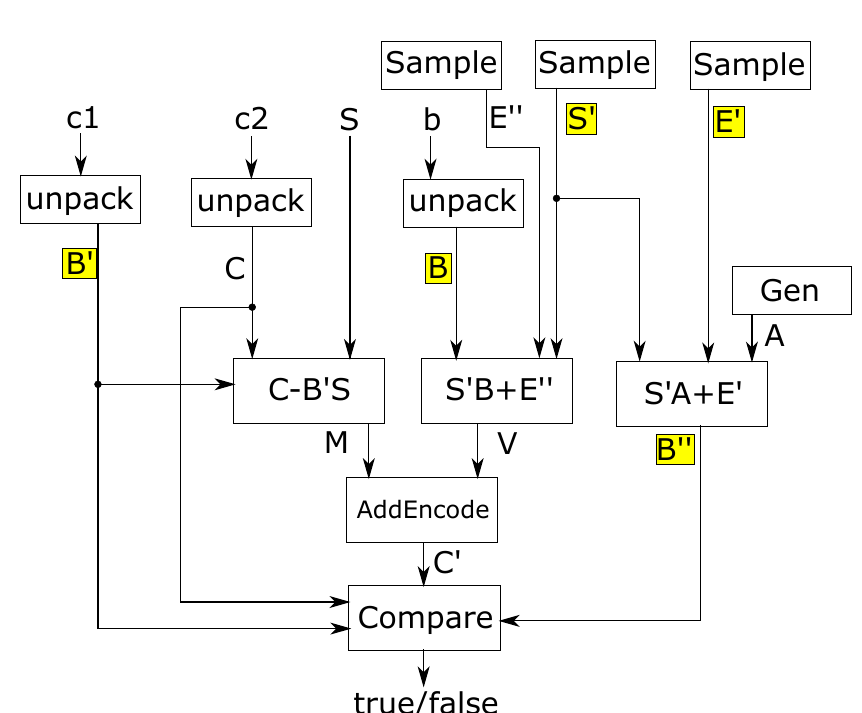
Figure 4: Flowchart of the decapsulation. Yellow highlighted matrices are n × ¯ n